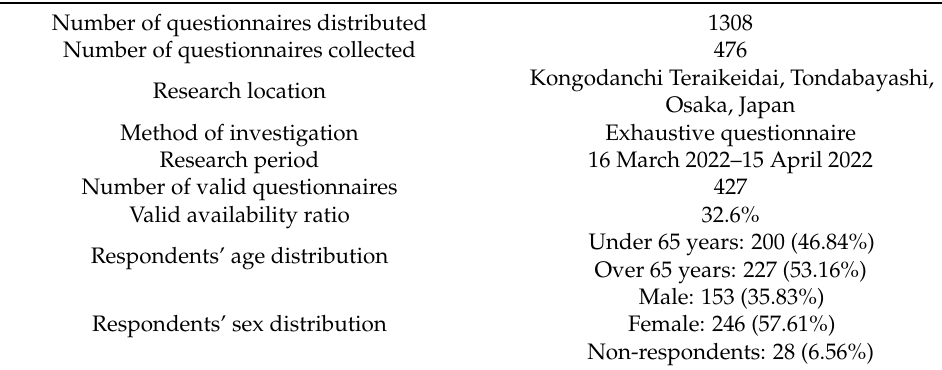
Table 1. Distribution and collection of questionnaires.